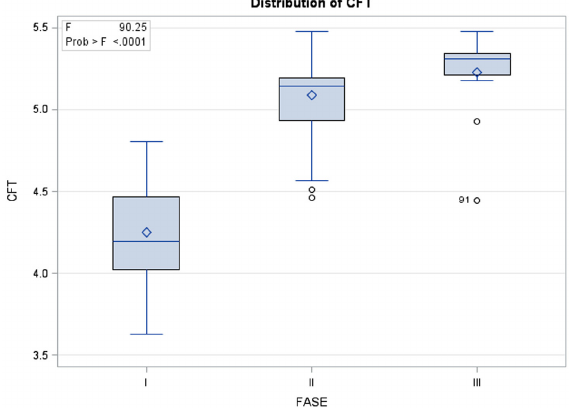
Figure 2. GLM procedure, demonstrating significant difference between phase I and phase II of a deslorelin treated